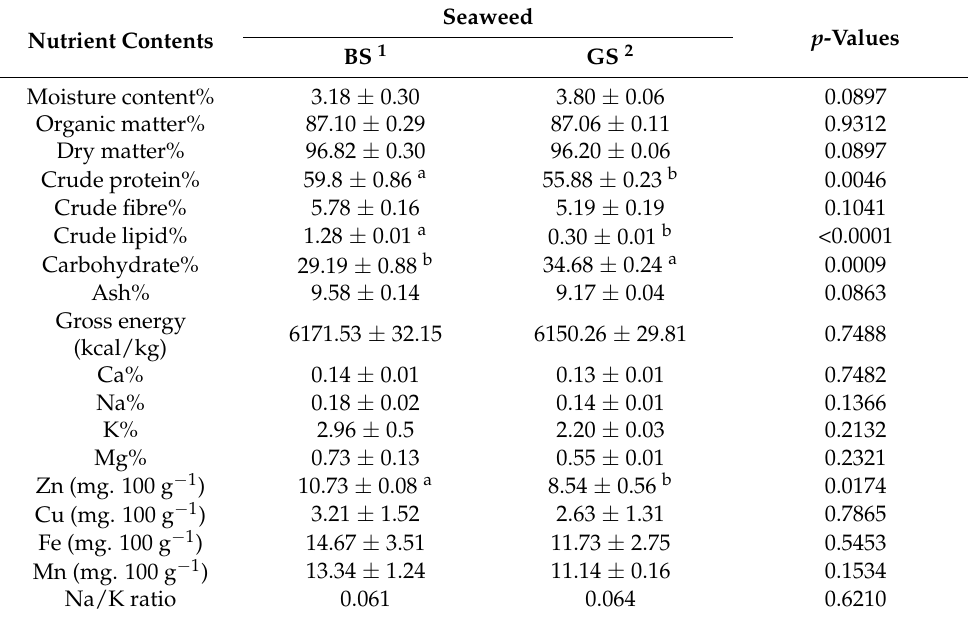
Table 3. Chemical compositions of seaweed (dry